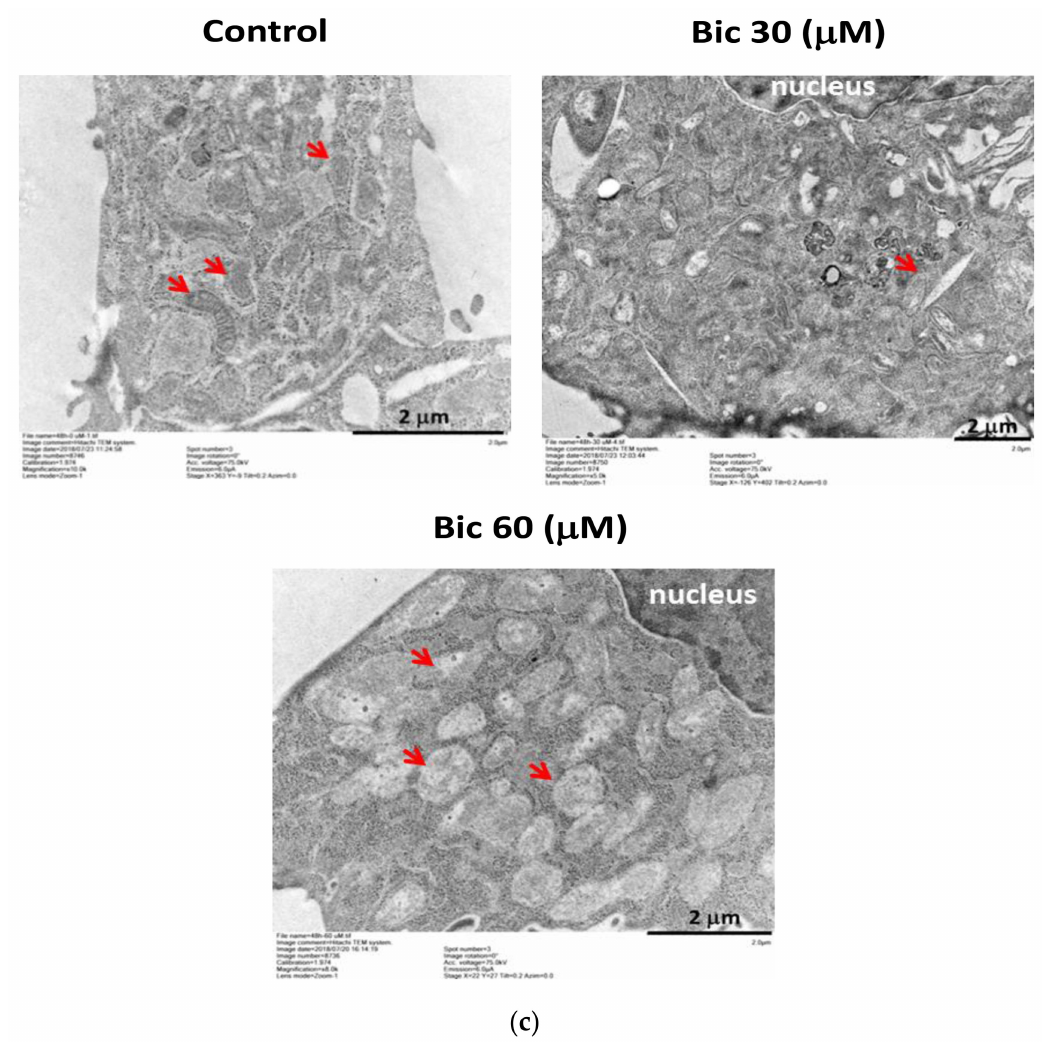
Figure 3. Estimation of the mitochondrial membrane potential and morphological changes. ( a ) Cells were treated with bicalutamide (Bic) at 30 and 60 µ M for 24 h. JC-1 staining showed changes in the mitochondrial potential a ff ected by Bic therapy. Scale bar = 250 µ M ( b ) Living cell tomographic microscopy of rat mesangial cells (RMCs) a ff ected by Bic (60 µ M) at 48 h as viewed with Nanolive 3D cell explorer (microscale length: 20 µ m, magnification: × 400). Control images revealed mitochondria containing many fibrous structures (indicated by a red arrow, also see enlarged insert), which were less seen in Bic (60 µ M)-treated cells and clusters of lysosomes instead appeared in treated cells (indicated by a green arrow, also see enlarged insert). ( c ) Morphological changes in mitochondria after being treated with Bic at 30 and 60 µ M for 48 h. As seen, the mitochondria treated with 30 µ M Bic were only slightly swollen, while those treated with 60 µ M were severely swollen ( red arrow: mitochondria). Scale bar = 2 µ